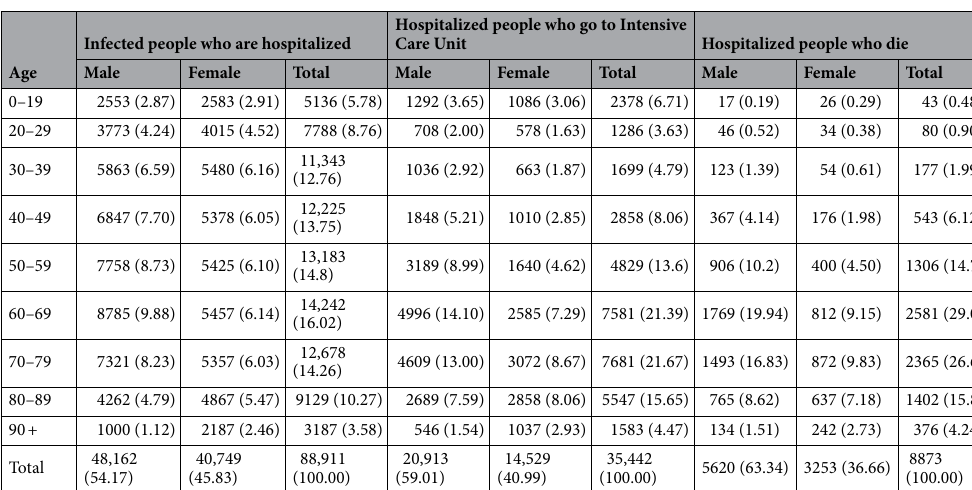
Table 1. Mathematical statistics calculation results by age and sex based on cases from CSSE. In Table 1, patients infected with SARS-CoV-2 were divided into six groups according to the sex, outcome and important time nodes. They were male/female cases who were infected with SARS-CoV-2 and hospitalized, male/ female cases who were hospitalized and sent to ICU, and male/female cases who were hospitalized and died. According to age composition shown in Table 1, patients infected with SARS-CoV-2 were divided into 9 groups, including 0–19 years old group, 20–29 years old group, 30–39 years old group, 40–49 years old group,